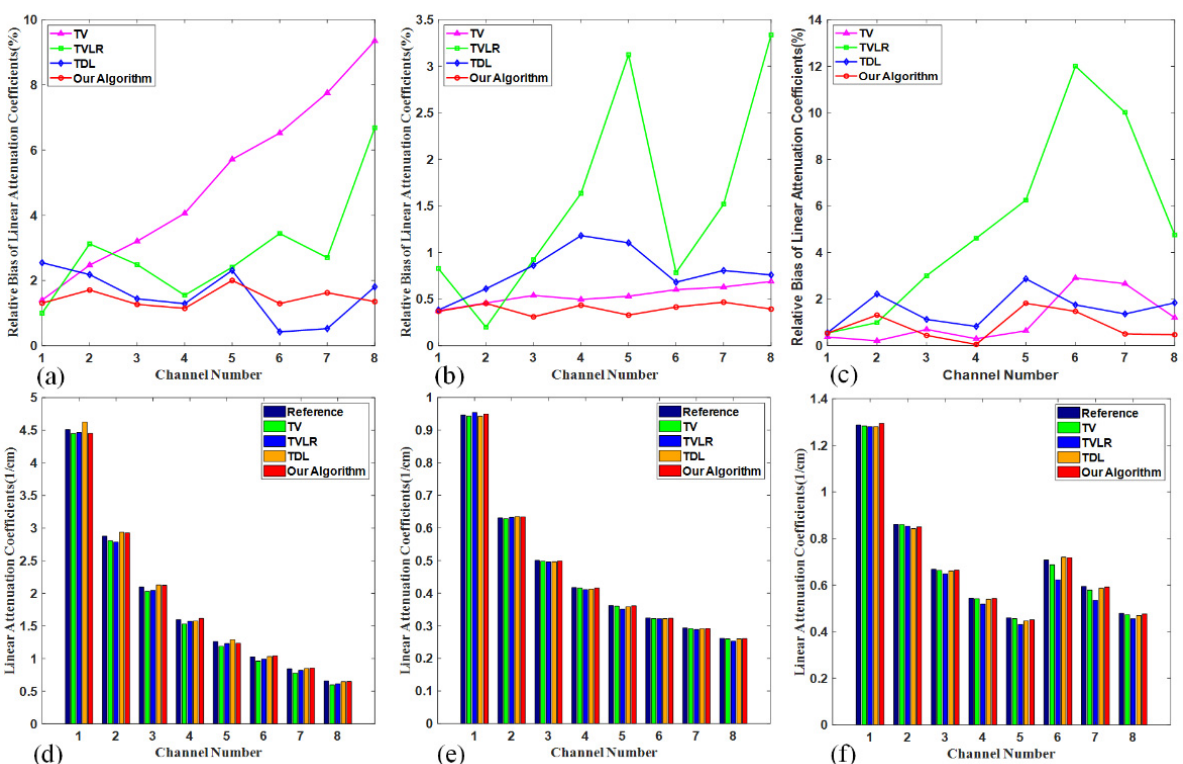
Figure 6. Mean values of three basic materials in each channel ( bottom ) and the corresponding relative bias ( top ). From left to right is bone ( a , d ), soft ( b , e ), and iodine contrast ( c , f ). Photonics 2022 , 9 , 35